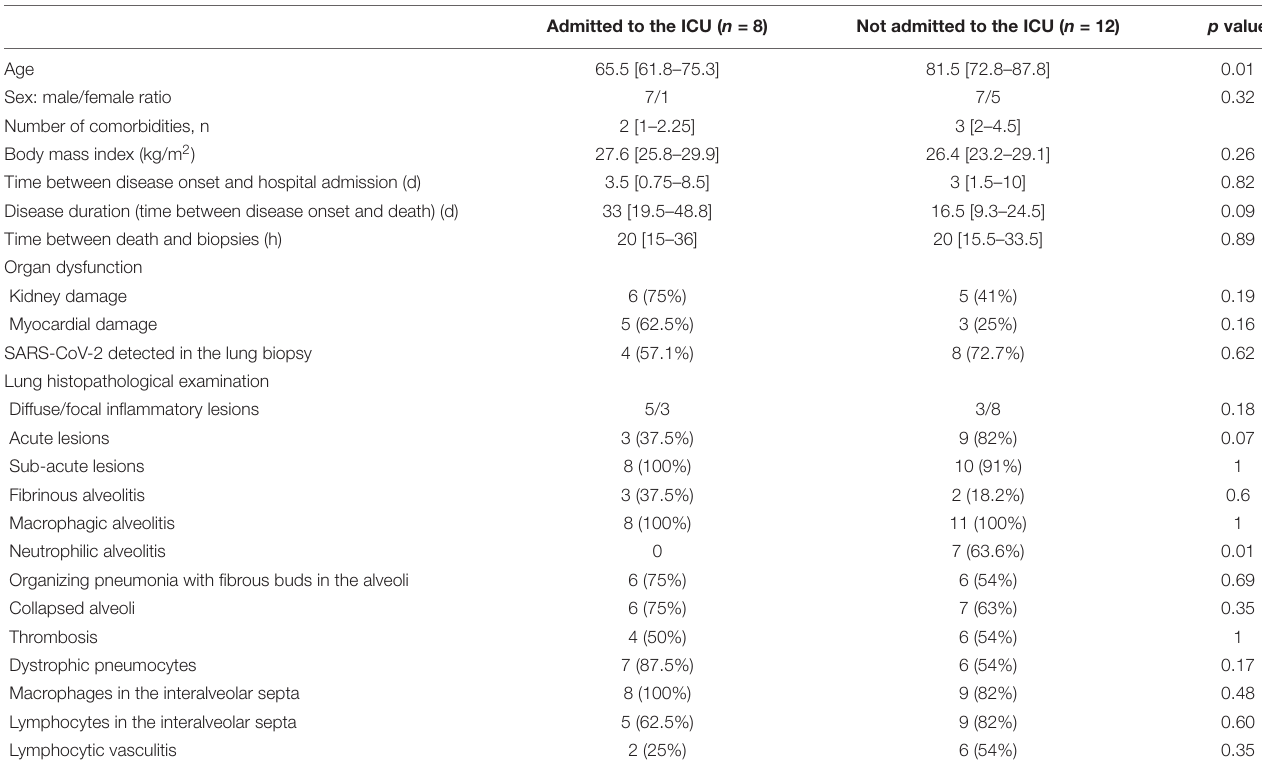
TABLE 3 | Patient characteristics as a function of ICU admission.